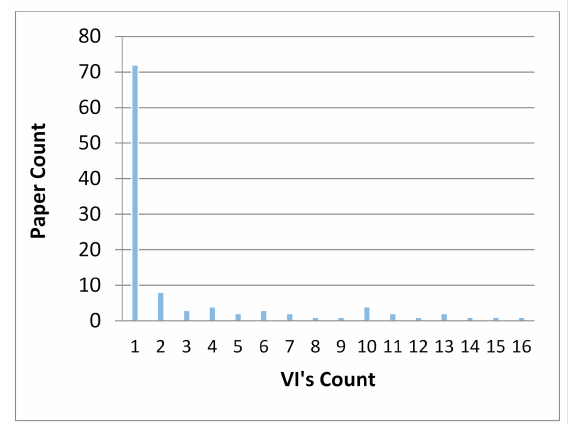
Figure 8. The number of vegetation indices applied per paper.